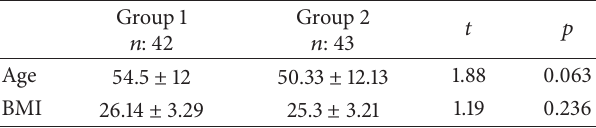
Table 1: Age and BMI data of the groups.